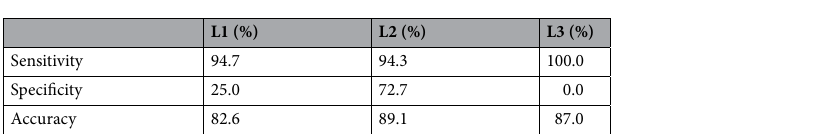
Figure 3. Cross-validation for ECRS discriminant score of the prediction model from ECRS’s alpha amplitude regarding 3 learning indices (L1, L2, and L3). The vertical dashed line indicates the boundary for responder classification from the discrimination score of an ECRS alpha amplitude model. The horizontal dashed line indicates the boundary for responder classification from a learning index. Each symbol represents a participant as either responder with right prediction (TP, black circle), nonresponder with right prediction (TN, red triangle), responder with wrong prediction (FN, green cross), or nonresponder with wrong prediction (FP, blue cross).